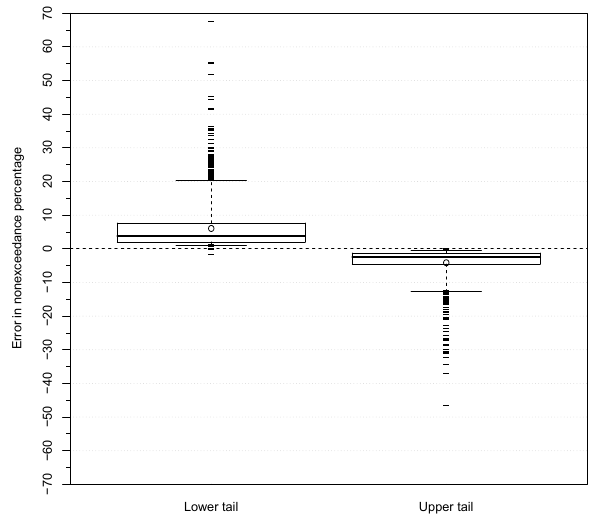
Figure 8. Distribution of mean error in the simulated nonex-